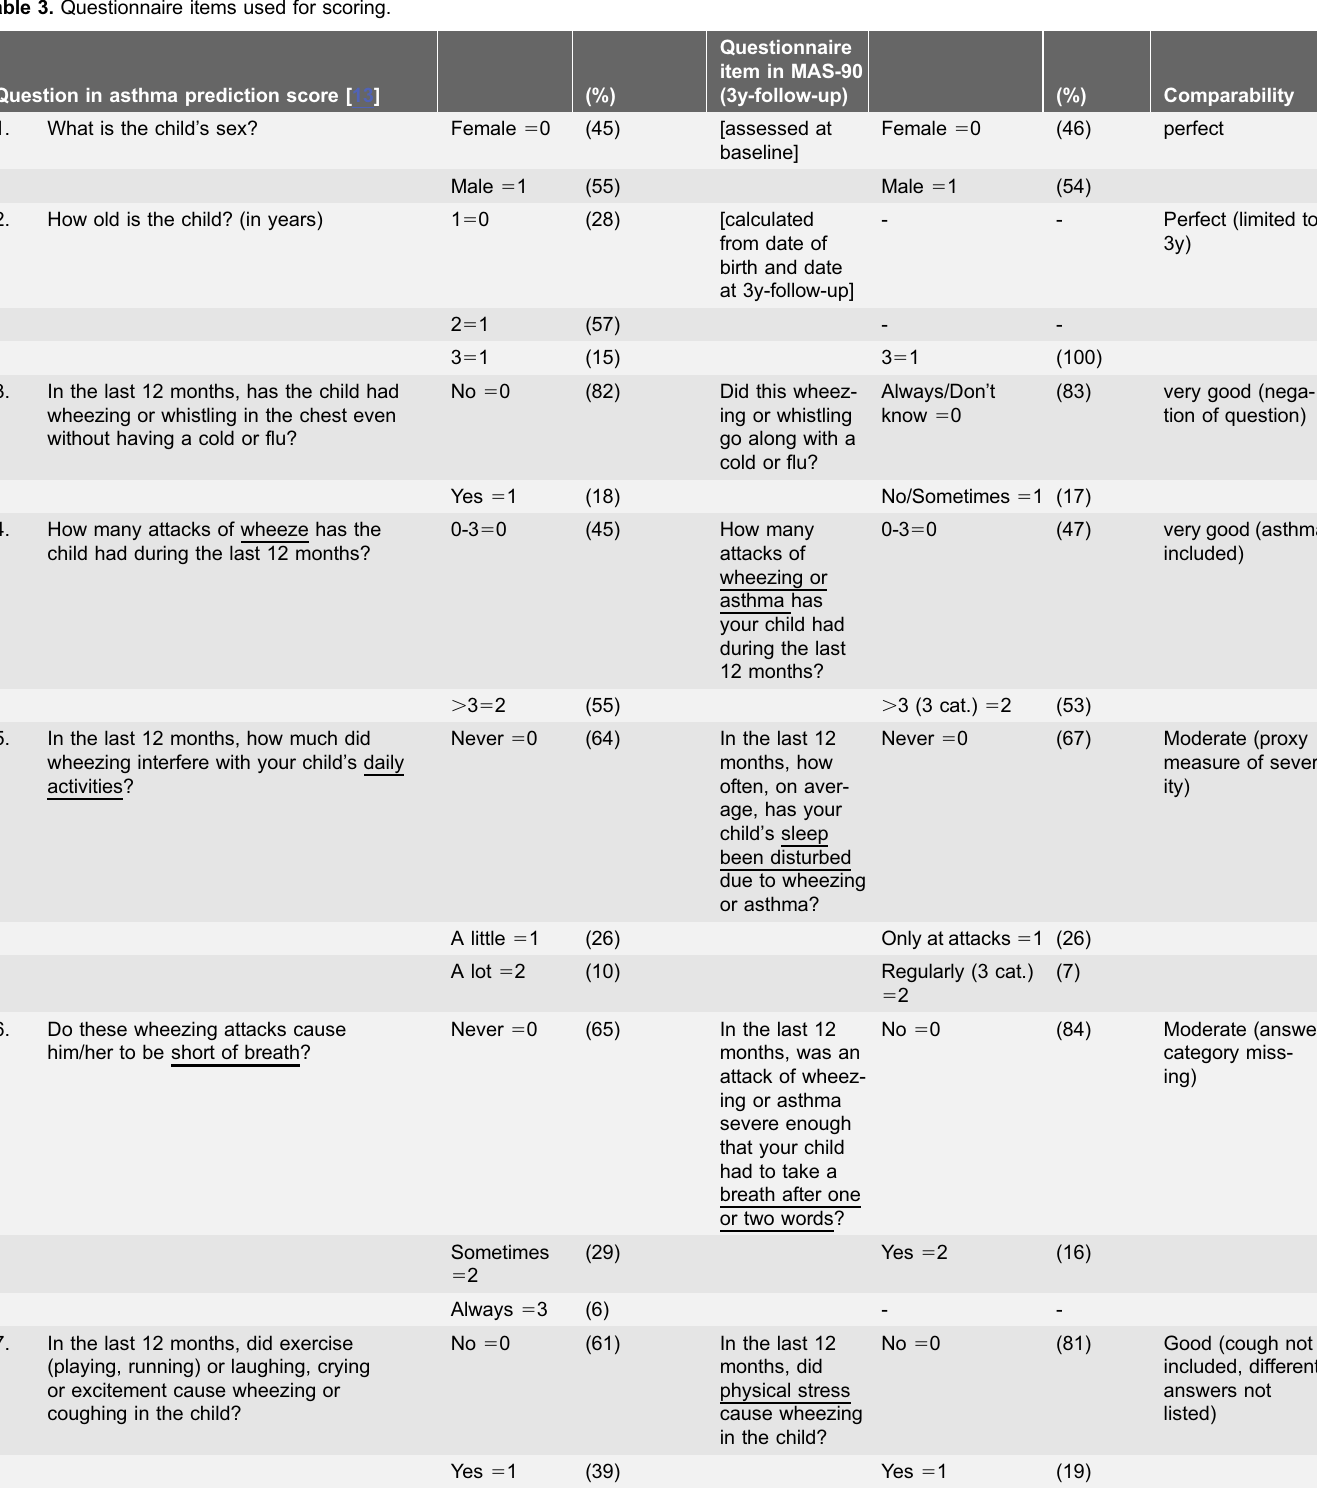
Table 3. Questionnaire items used for